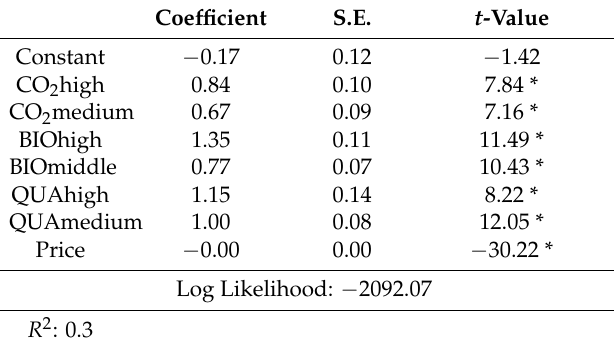
Table 3. Estimation results of conditional logit